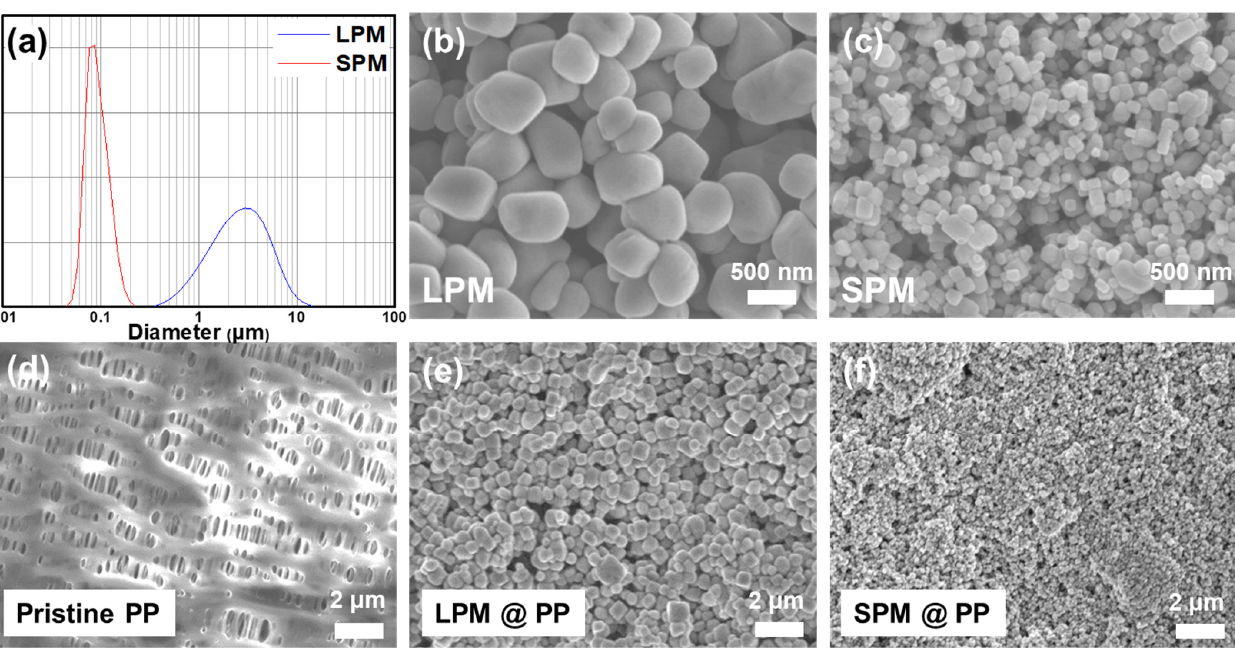
Figure 1. Schematic illustration of the polarization process occurring in the pristine PP separator ( top ) and the PM-coated separator ( bottom ).